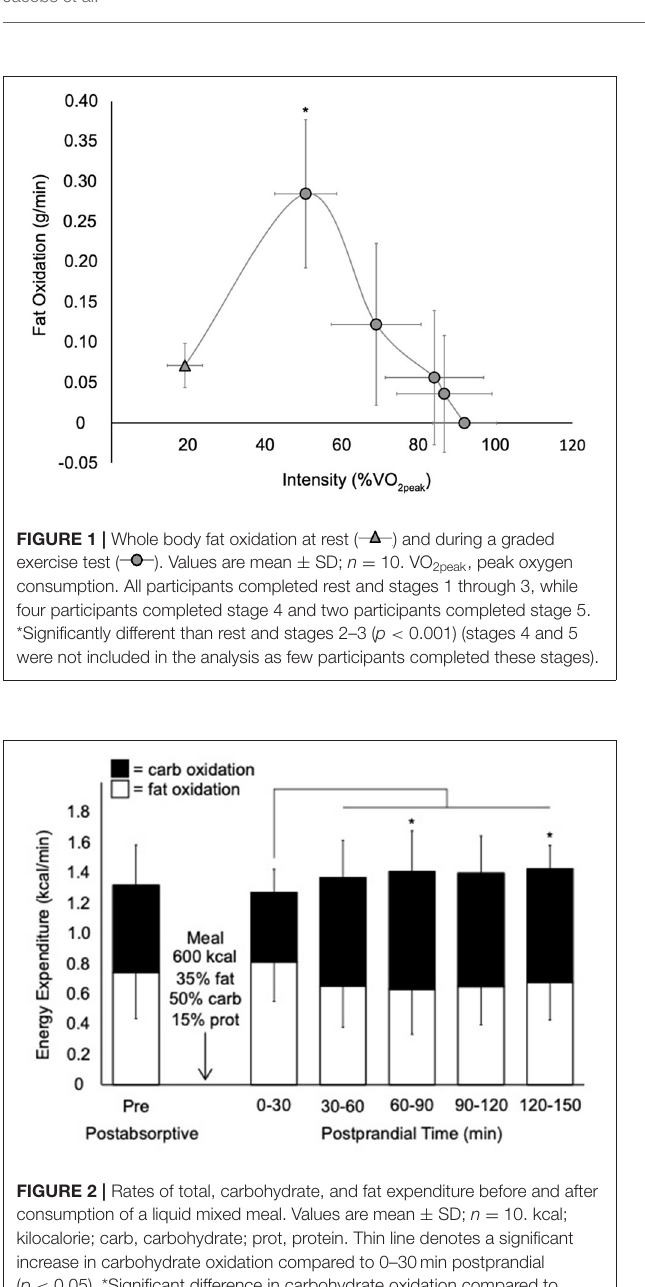
p = 0.062). The average peak FO during the postprandial period was 0.10 ± 0.03 g/min (0.07–0.16 g/min).